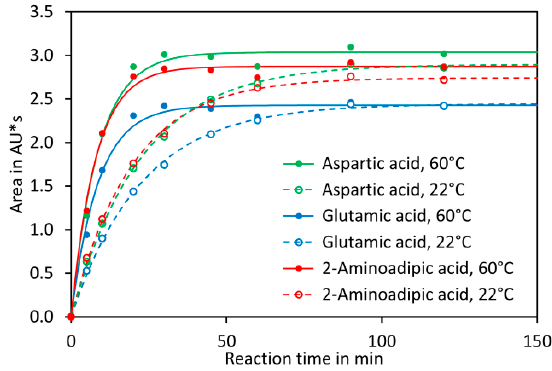
Figure A2. Kinetics of derivatisation at 60 °C and 22 °C. A mixture containing aspartic, glutamic, and 2-aminoadipic acid was derivatised with 30 mM DNFB in sodium borate buffer pH 9.5 at 60 °C and room temperature (22 ◦ C). The reactions were stopped at the indicated time points and the samples analysed by Table A1. Analysis of glutamate in different tomato cultivars by UHPLC and an enzymatic test.